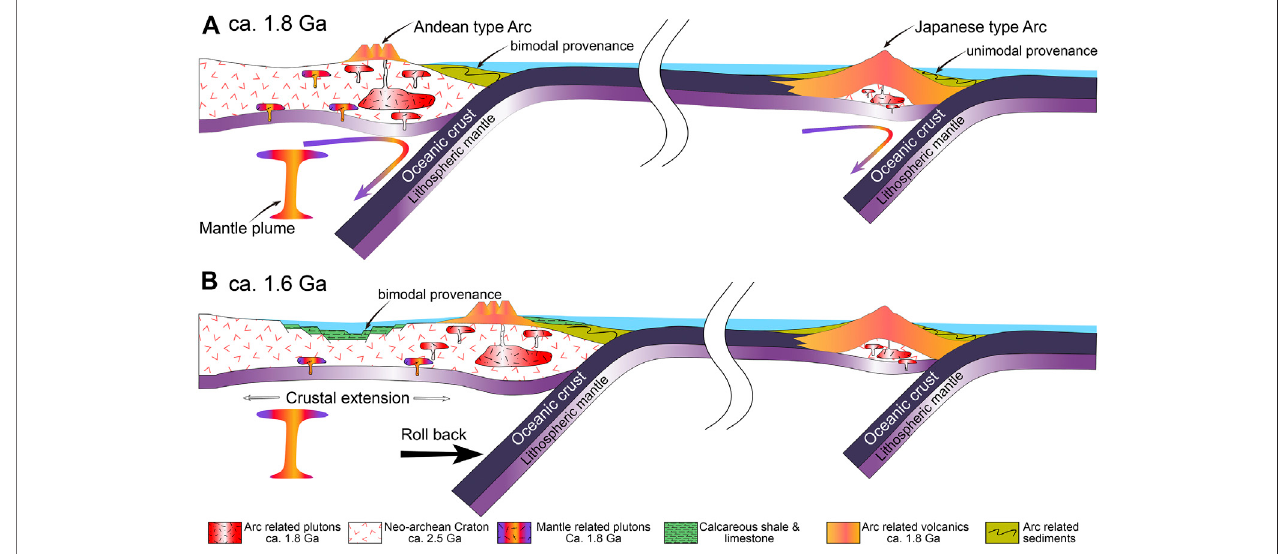
FIGURE12 | Schematic diagrams ofthe LatePaleoproterozoic evolution of atwo-arc system ofthe northern Indian Craton (left) and the newly de fi ned Japan-type arc(right),modi fi edfromthestudybyMandaletal.(2016). (A) Atca.1.8 Gathereexisted atwo-arcsysteminthenorthern IndianCratonanditsoceanicnearbydomain. The Japanese-type arc contained limited Neoarchean crust material which melted as a magma chamber, which provided a unimodal source to the sediments. In contrast, the Andean-type arc provided a bimodal source for the sediments. (B) At ca.1.6 Ga, rollback of subduction slab and a mantle plume in the Andean-type arc resulted in back-arc rifting in the northern Indian Craton. The gap between the two arcs represents a remote location of the Japanese-type arc, far away from the Andean-type arc (see the text for detailed explanation).